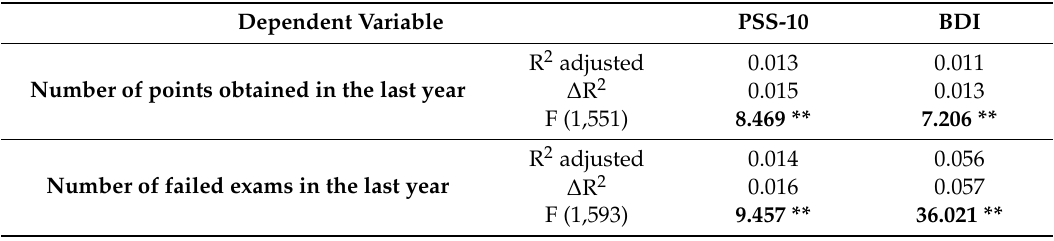
Table 7. Regression analysis using academic performance as